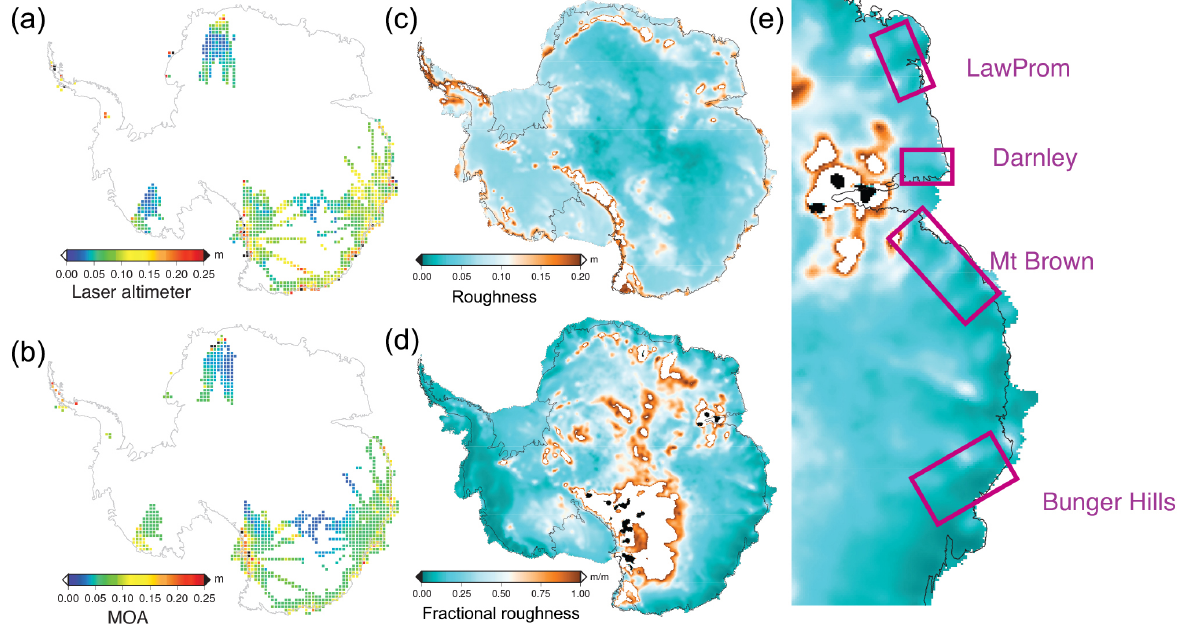
Figure 2. MODIS-based surface roughness estimates. Panel (a) shows the calculated average surface roughness in each 50 × 50km 2 grid, from Operation IceBridge, ICECAP and other University of Texas at Austin Institute of Geophysics Level 2 Geolocated nadir laser altimetry flight-line data (Blankenship et al., 2012; Young et al., 2015). Panel (b) shows the resultant estimate of surface roughness from MODIS Mosaic of Antarctica (MOA) imagery, by calibrating it with the averaged surface altimetry calculated in panel (a) (see the “Method” Section (Sect. 3.3.2)). Panel (c) shows the estimated (modelled) surface roughness for Antarctica using the laser altimetry-calibrated MOA imagery, while panel (d) shows estimated surface roughness as a fraction of estimated annual snowfall accumulation rate from RACMO2.1. In this instance, blue regions (low fractional roughness) indicate regions with minimal surface reworking as a fraction of snowfall accumulation rate and hence potential high-resolution ice coring sites. Panel (e) is the enlarged coastal East Antarctic section of the fractional roughness (panel d